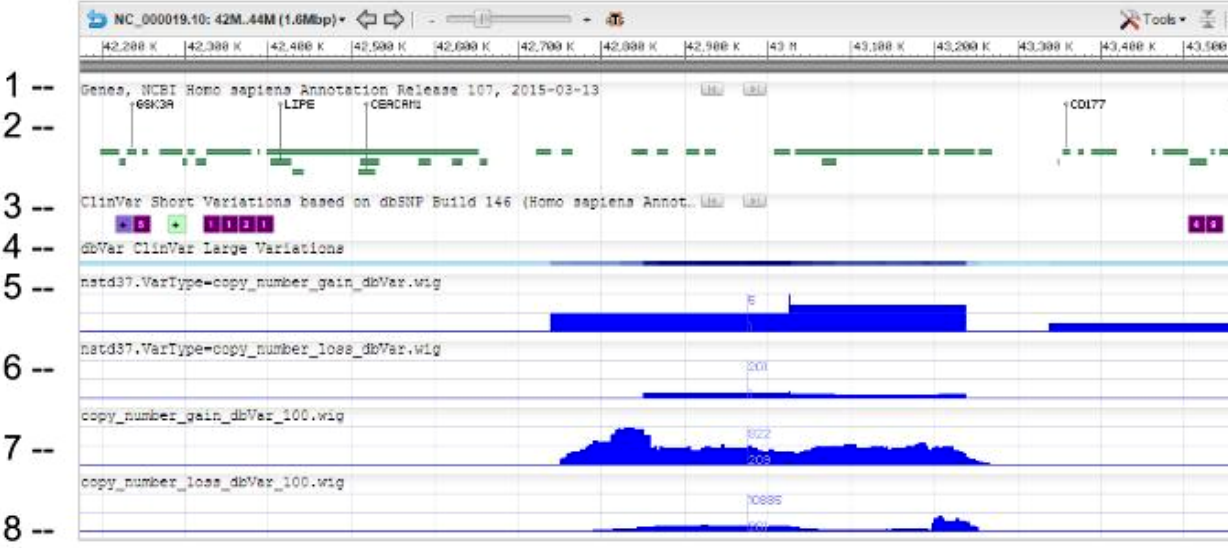
Figure 5. Magnified region of Chr19 showing a region of high density of variants where SVCs presumed to be common are also found. The tracks and histogram scales are as described in Figure 3.